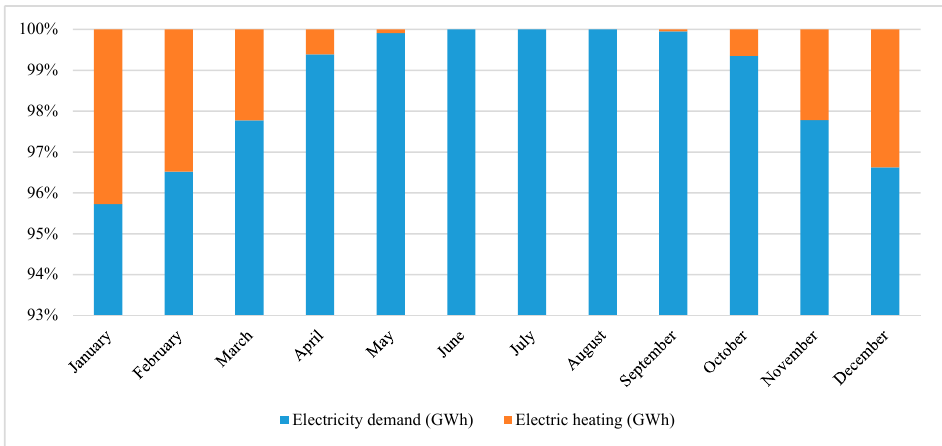
Figure 2. Electricity demand including electric heating for year 2030. Energies 2019 , 12 , x FOR PEER REVIEW